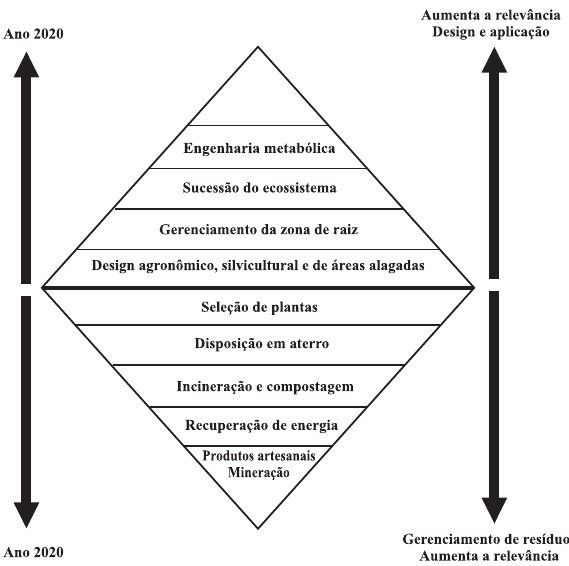
Figura 1. Evolução da fitorremediação: estratégias em busca de melhoria nas fases pré-colheita (setas para o alto) e pós-colheita (setas para baixo) (adaptado de McCutcheon & Schnoor,